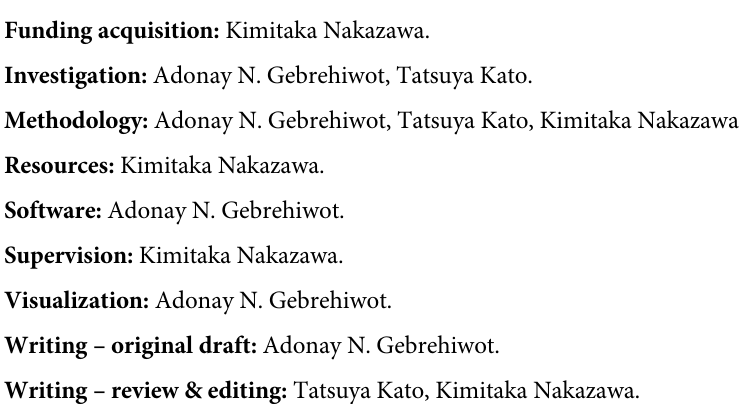
S1 Table. Individual raw data. The following table includes participant responses during the experimental condition. Note that responses for the control condition are not shown since all participants responded “no.” The top section corresponds to the different virtual environ- ments (VE). The number of left (L) and right (R) turns are organized for each participant. S2 Table. Participant information. The table includes those who were able to perceive phos- phenes, but fell short of achieving the phosphene threshold required to continue the study. S3 Table. Participant phosphene information. The following tables include the TMS intensi- ties from participants disclosed in S2. The reported TMS intensities reflect the first instance where a phosphene was observed by each participant. Thereafter, TMS intensity output was incrementally increased until reaching the maximum stimulator output. Consequently, since the phosphene threshold criteria was not achieved, these participants were excluded from the study. Finally, intensities for the remaining five participants are not reported since they were not able to perceive any